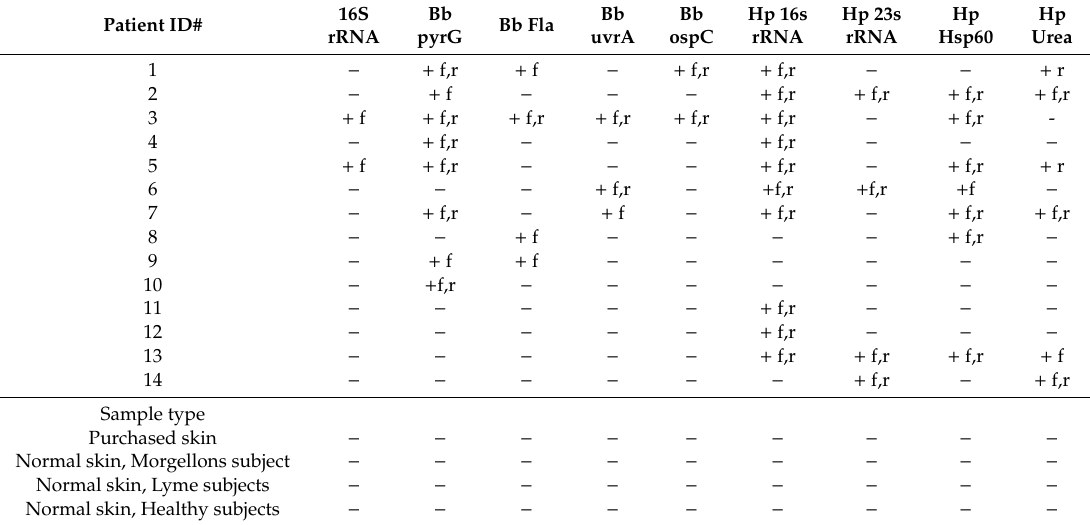
Table 4. PCR amplification of Bb and Hp target DNA, confirmed by